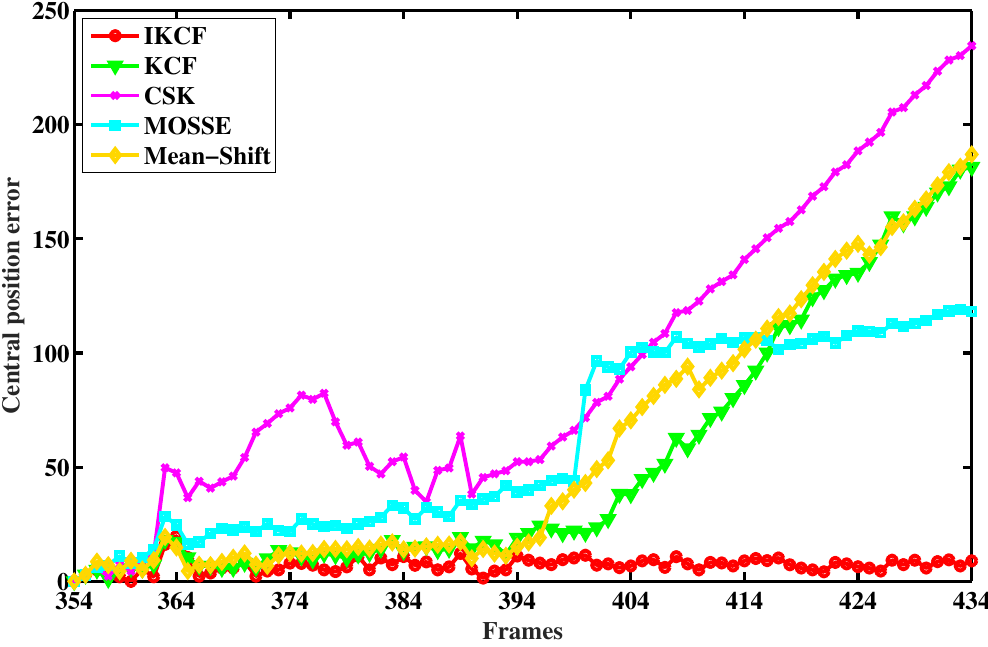
Figure 13. Center position error curves (354th frame to 434th frame).